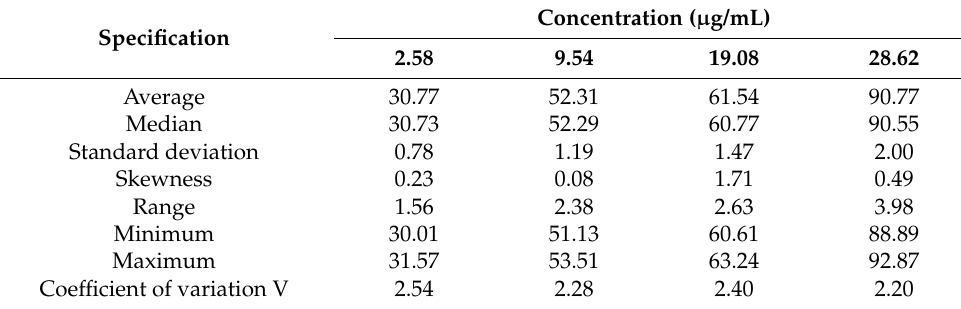
Table 11. ABTS radical scavenging activity of leaves of Thymus algeriensis essential